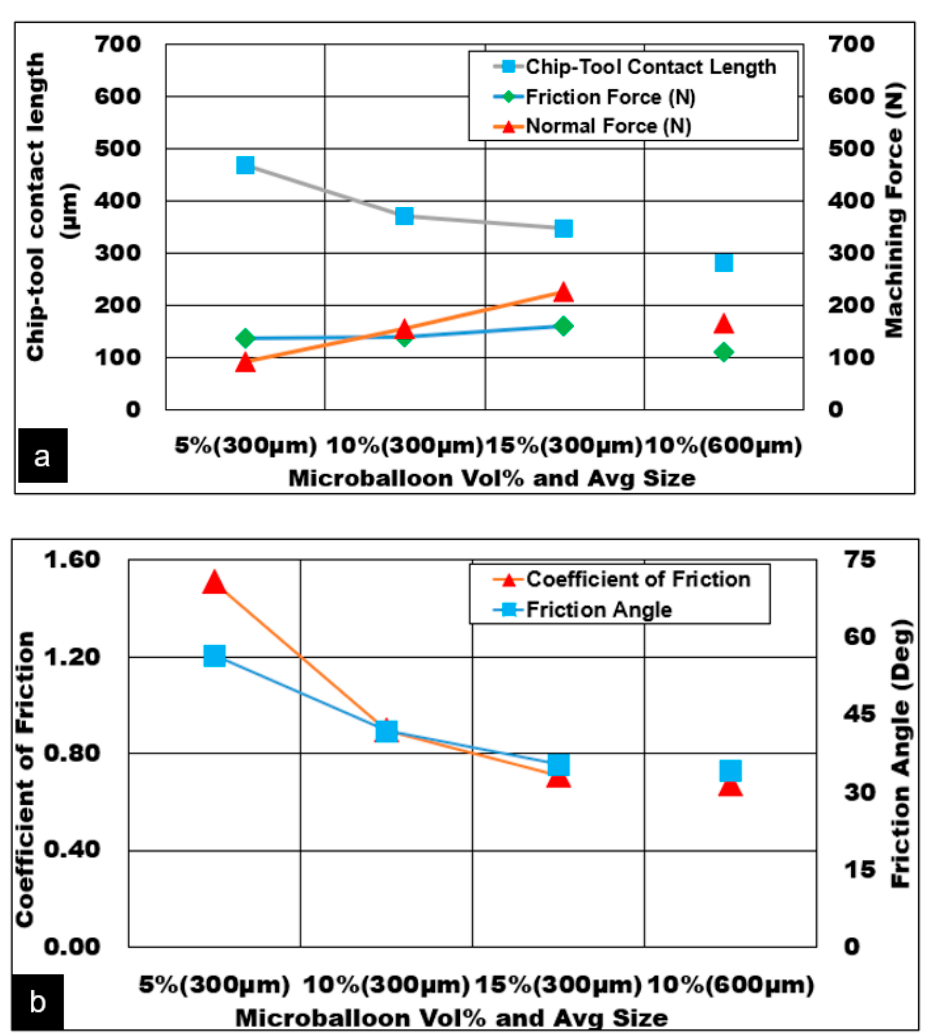
Figure 8. Friction force predictions: effect of hollow alumina vol% and average diameter. AZ31 / hollow alumina bubble syntactic foam, (h = 0.1 mm, Vc = 50 m / min, b = 3 mm), ( a ) Mg/hollow alumina bubble syntactic foam, (h = 0.1 mm, Vc = 50 m/min, b = 3 mm), ( a ) volume fraction AZ31 Mg